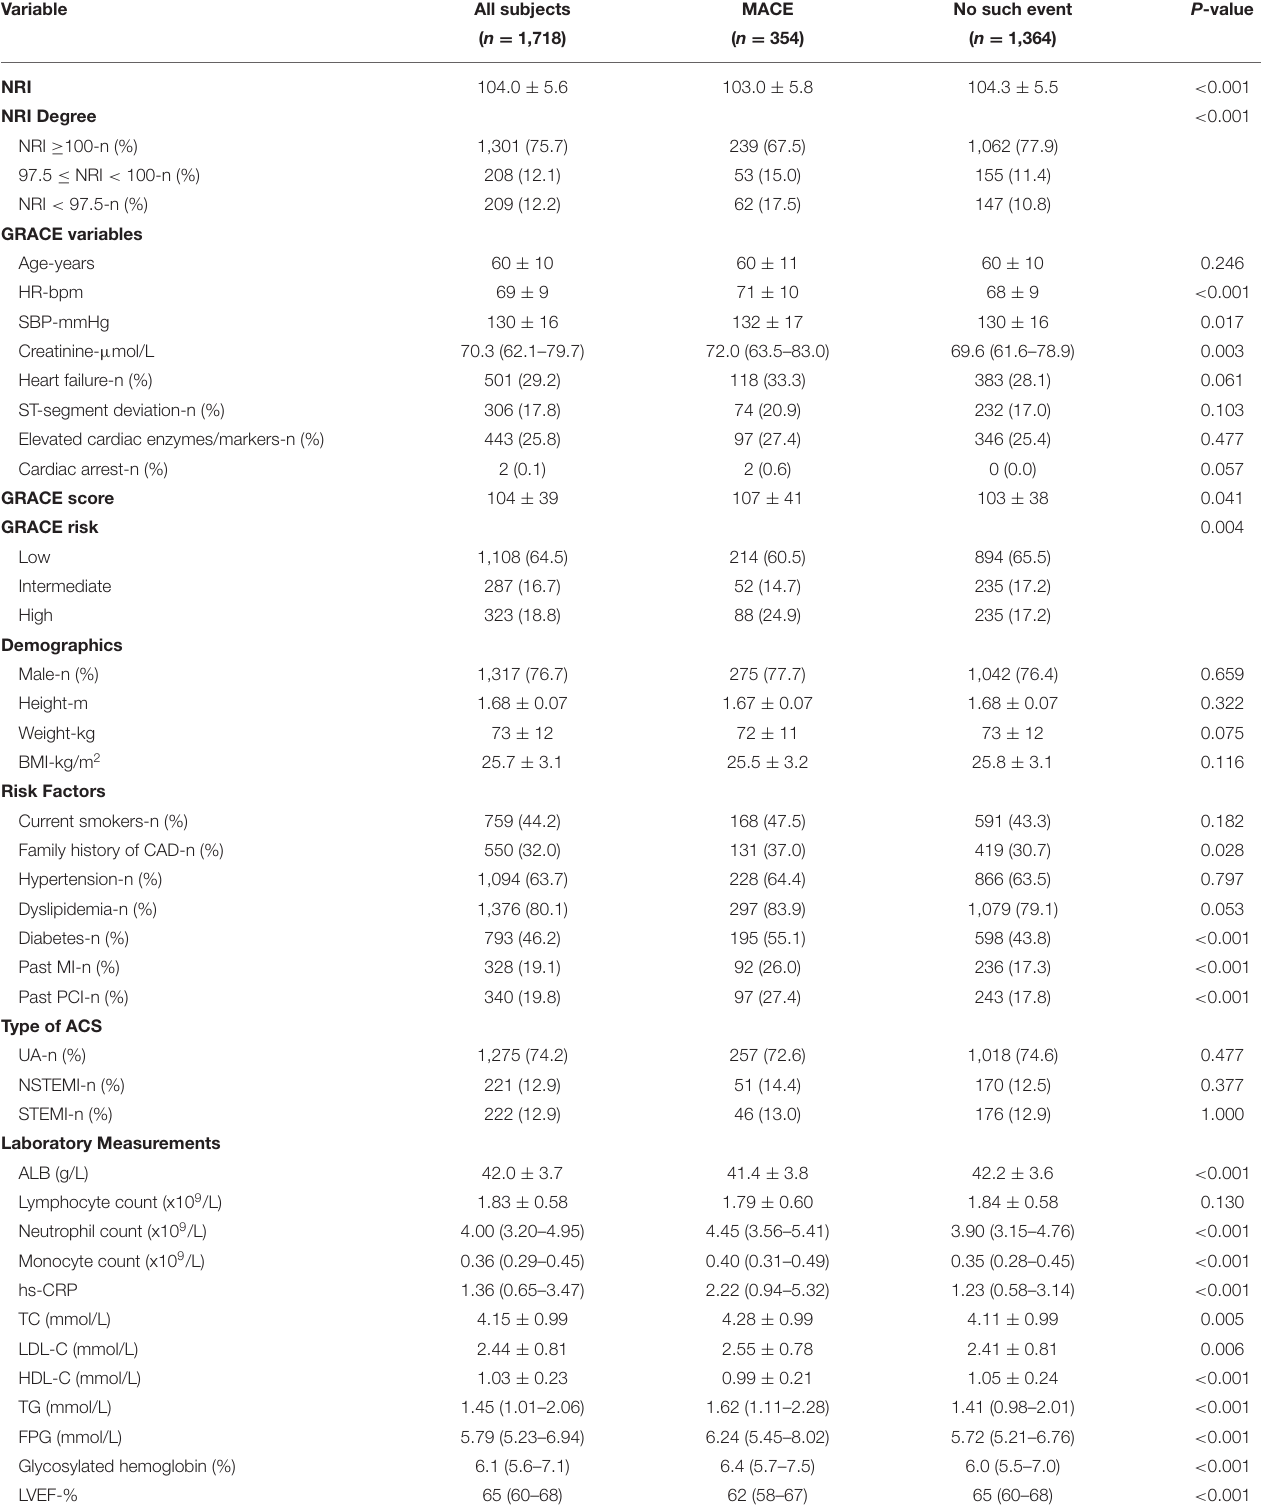
TABLE 2 | Baseline characteristics of study subjects by